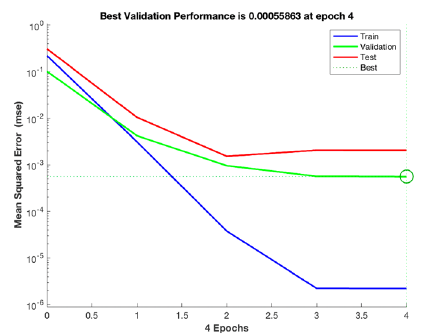
Figure 6. Evolution of MSE during the ANN training phase.